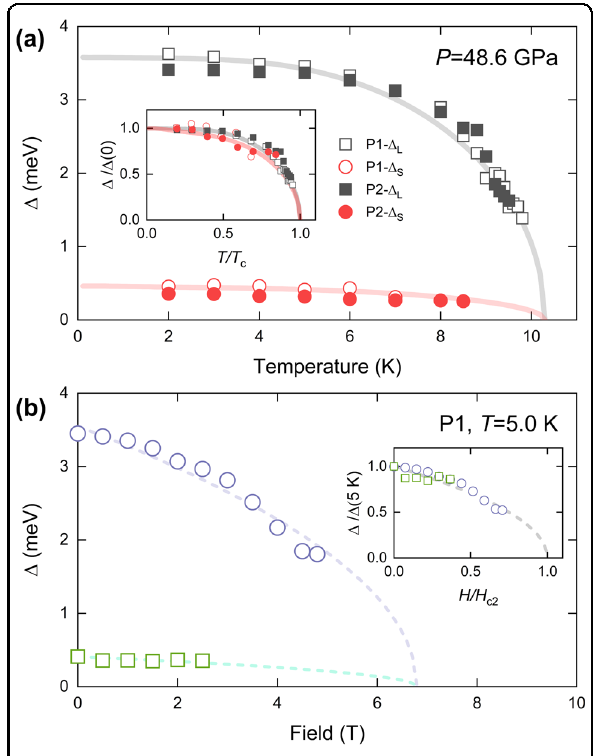
Fig. 4 Temperature and magnetic fi eld dependence of the superconducting gap of Y. a Temperature dependence of the two superconducting (SC) energy gaps obtained from different contacts P1 (open symbols) and P2 (solid symbols) at 48.6 GPa. The black and red lines are the best fi ts using the two-band s -wave BCS framework (see the main text for details). The reduced SC energy gaps for contacts P1 and P2 against reduced temperature are plotted in the inset. b Magnetic fi eld dependence of the two SC energy gaps from P1 at 48.6 GPa and a fi xed temperature of 5.0 K. The short-dashed lines are the estimated power-law behavior, Δ ( H , 5.0 K) = Δ (0, 5.0 K)·(1 − H / H 1/2 . The reduced energy gaps as a function of the reduced fi eld are c2 ) plotted in the